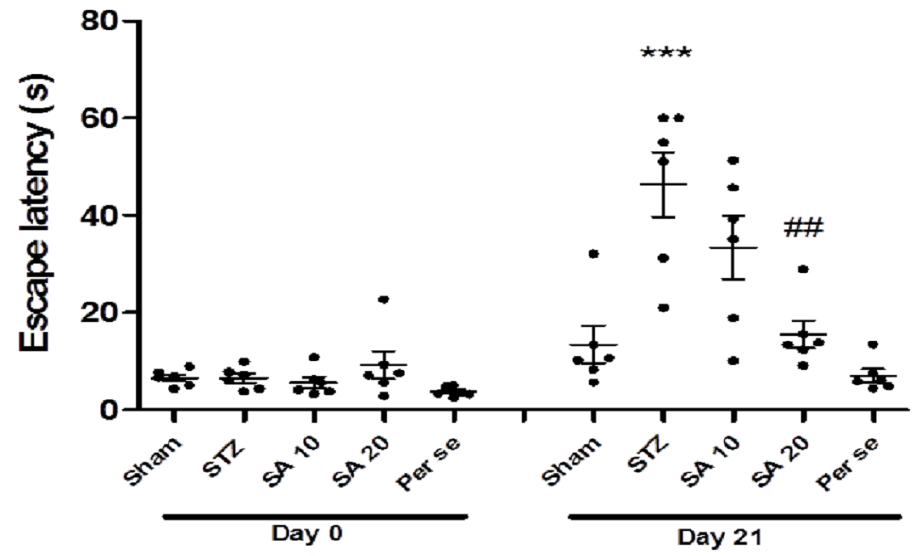
Figure 2. Effect of sinapic acid on latency to reach the platform zone. Data are presented as mean ± SEM, ( n = 6). * as compared to the sham group, # as compared to the STZ group. *** p < 0.001, ## p < 0.01. STZ—Streptozotocin, SA—Sinapic acid.